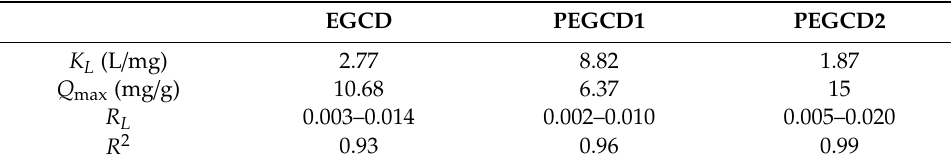
Table 2. Adsorption isotherm parameters for MB adsorption.